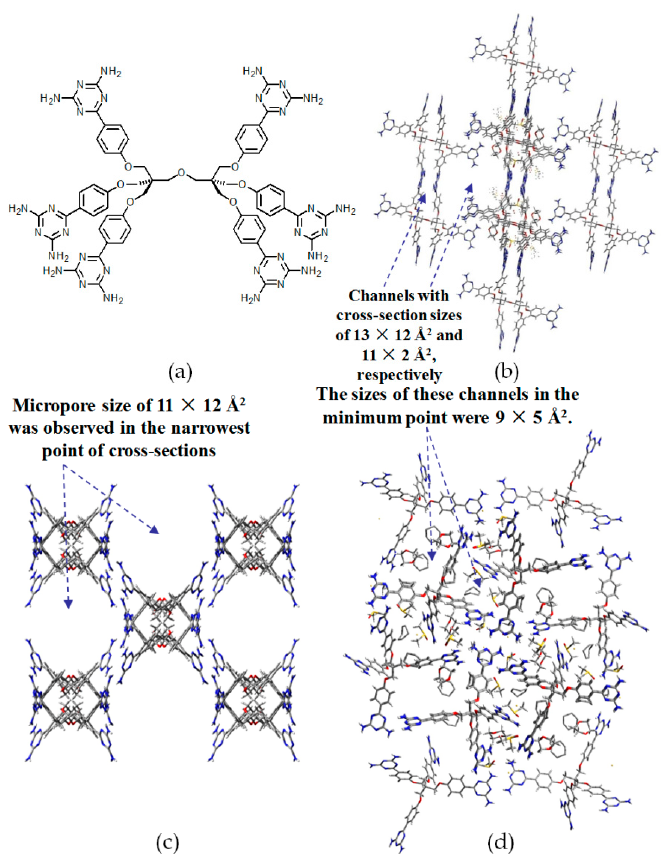
Figure 23. ( a ) Structure of building motif 26 ; ( b ) Crystalline network of H26 ; ( c , d ) Top views of H24a and H25a (with solvent guests), respectively.